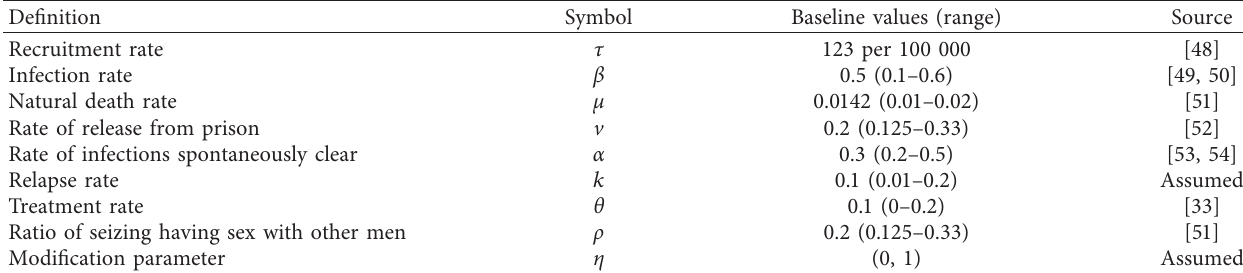
Table 1: Model parameters and their baseline values.